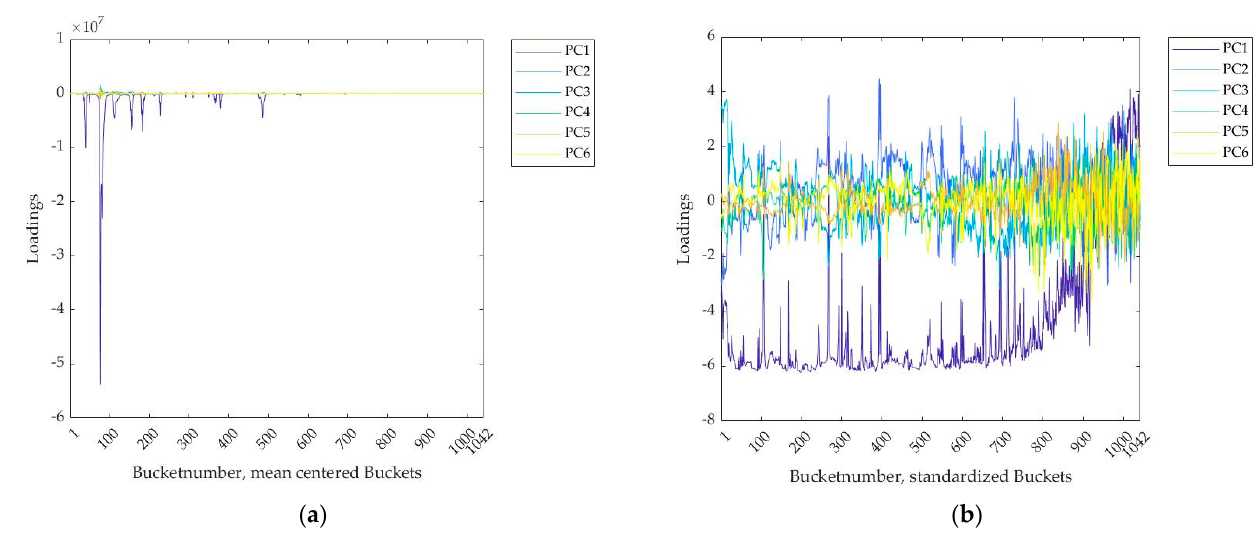
Figure 1. ( a ) Loadings from each bucket for every PLS component (PC), PLS regression (6 PLS components) with 40 commercial coffee samples and 1042 mean centered buckets for each sample; ( b ) loadings for each PLS component, PLS regression (6 PLS components) with 40 commercial coffee samples and 1042 standardized buckets each. Table 1. Comparison of variable selections based on PLS regression of mean-centered y-data and standardized x-data with six PLS components, PLS